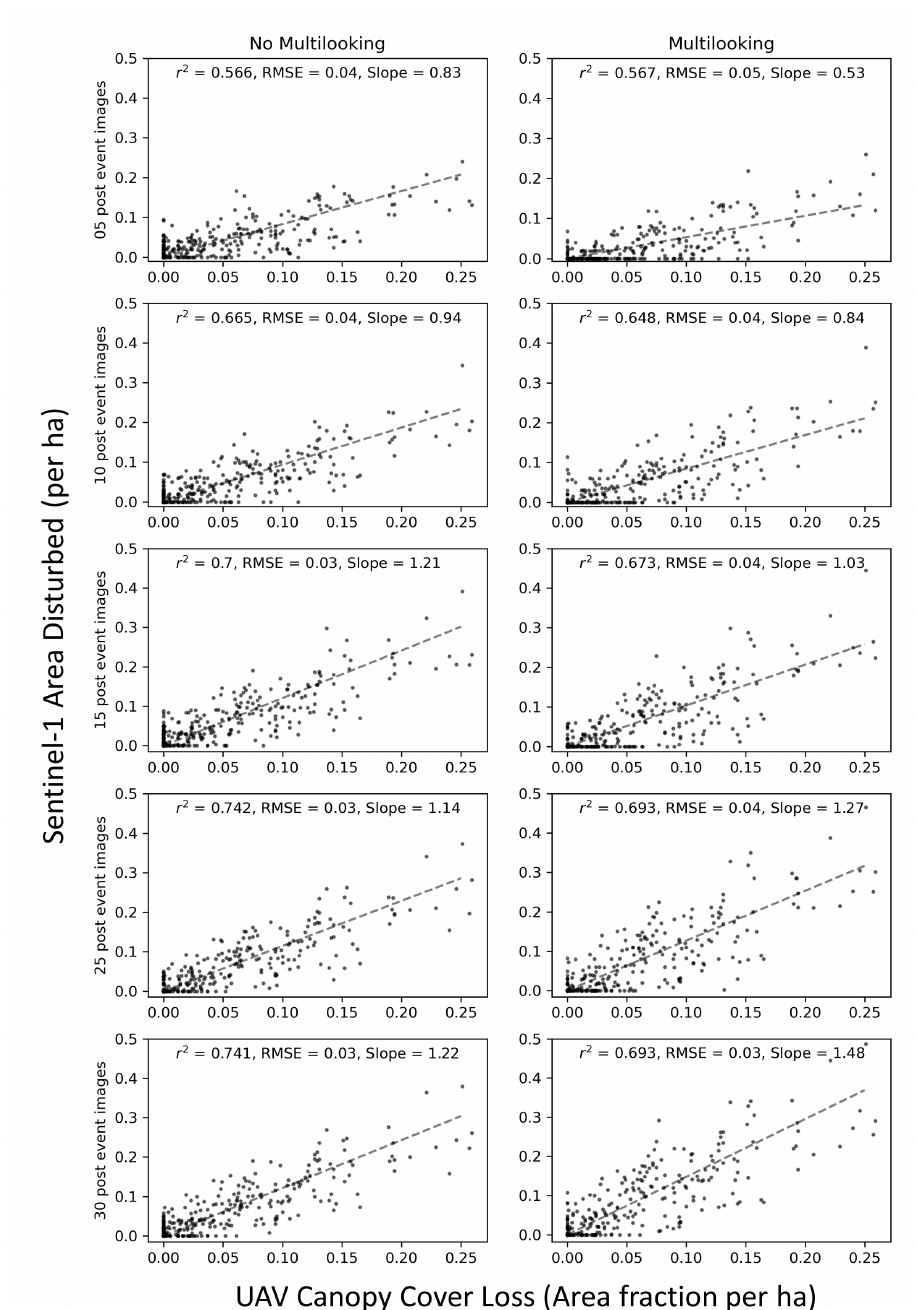
Figure A2. Area of Sentinel-1 Shadow per 1 ha cell vs. area of UAV LiDAR detected canopy gap. Results are separated for various values of n , the number of post-event images used in to estimate S-1 shadows, and according to whether 3 × 3 spatial multilooking was applied. In each case, the correlation coefficient r , root mean square error (RMSE) and ratio of S-1 shadows to UAV canopy gap area (slope) is